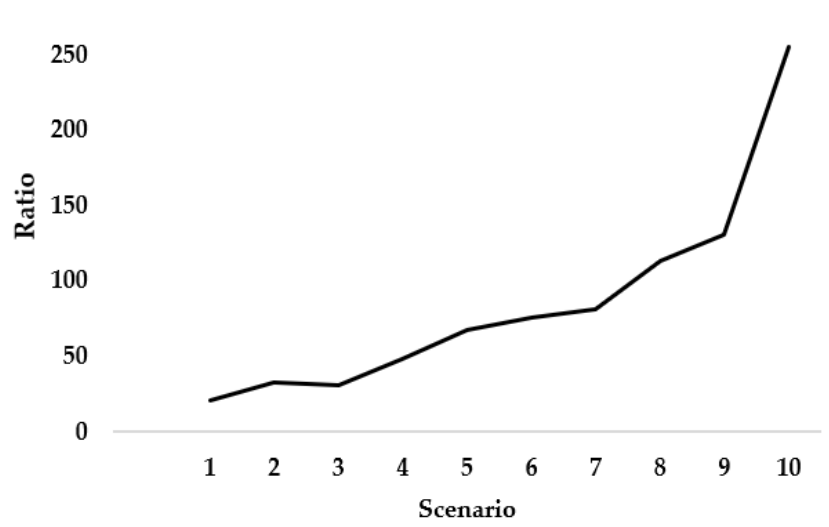
Figure 10. The ratio of T ′ 0 to the initial value of T0 in different scenarios.